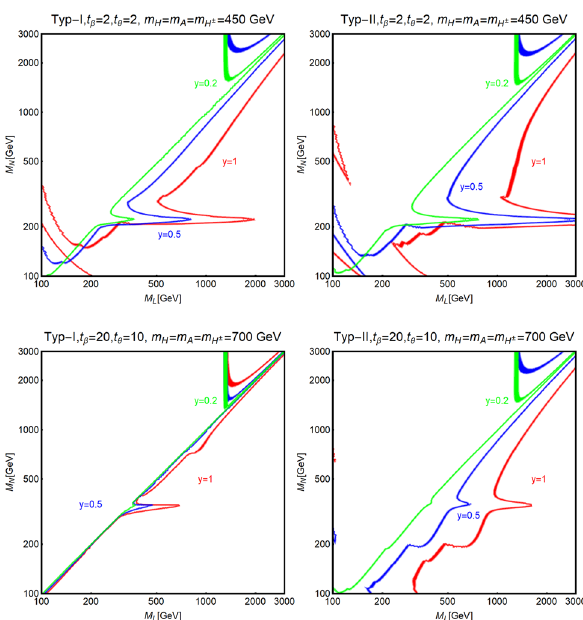
Fig. 2 IsocontoursofthecorrectDMrelicdensityinthebidimensional plane ( M N , M L ) for Type-I 2HDM (abbreviated as Typ-I in the plot) (upper panel) and Type-II (abbreviated at Typ-II) models (lower panel), for three values of y , namely 0.2, 0.5 and 1, and some assignations of the other relevant parameters, reported on top of the single